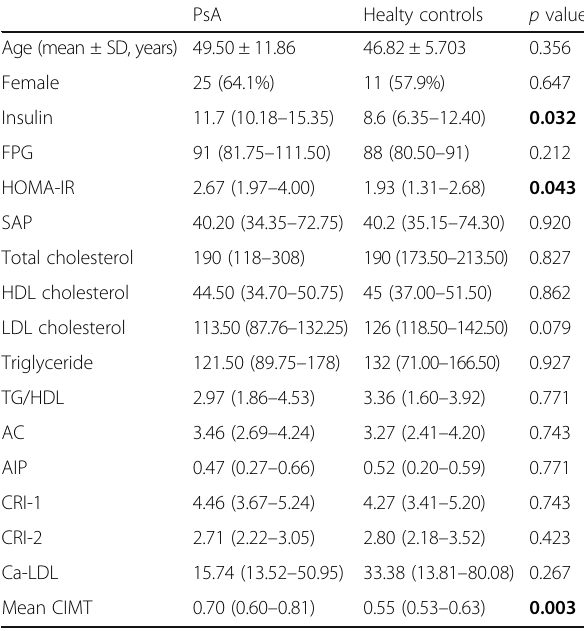
Table 1 Clinical characteristics and laboratory results of patients and healthy volunteers PsA Healty controls p value Age (mean ± SD, years) 49.50 ± 11.86 46.82 ± 5.703